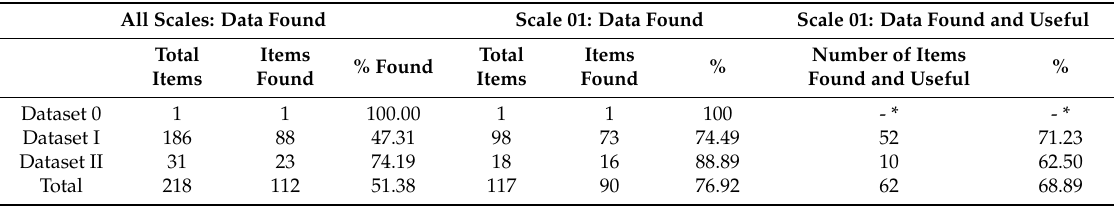
Table 6. Data gathered for all scales, data gathered specifically for Scale 01 and data finally computed into the sustainability assessment: Panajachel pilot site.